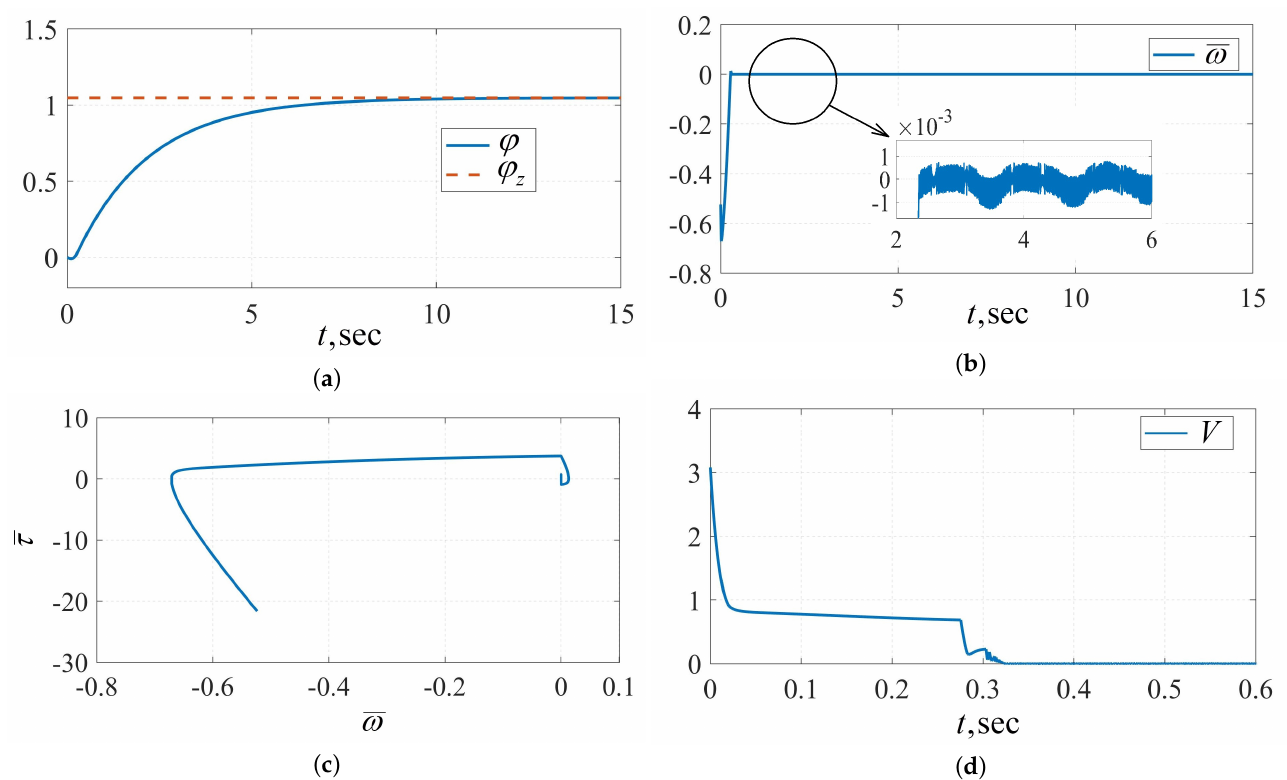
Figure 6. The simulation results of the closed-loop systems (59), (61) and (62). ( a ) Plots of ϕ ( t ) and ϕ z ; ( b ) Plot of ω ( t ) ; ( c ) Phase portrait of ω and τ ; ( d ) Plot of V ( t )